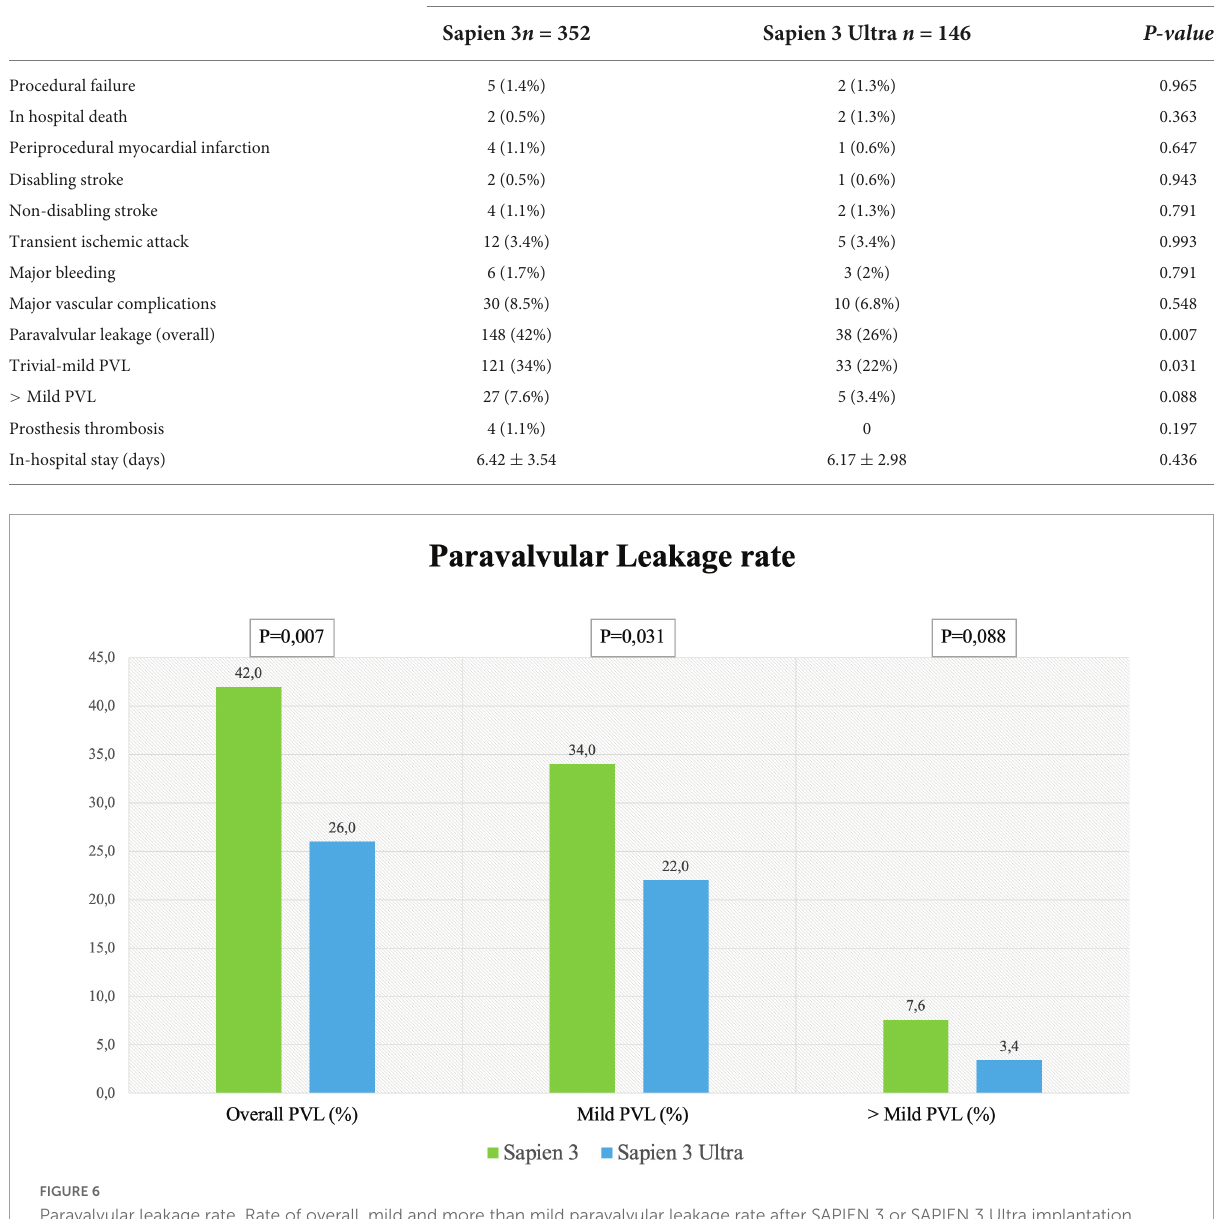
TABLE 3 In-hospital complications.